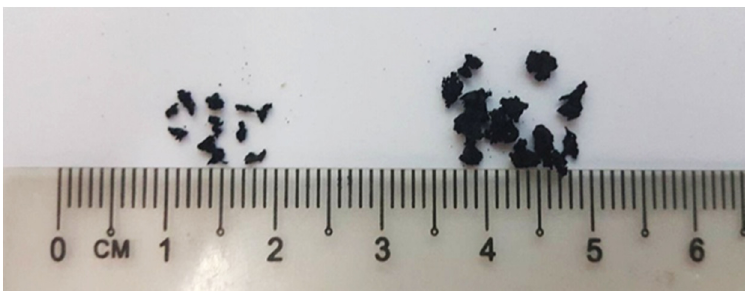
Figure 1. Crumb rubber with size range of 0.6mm to 2.36 mm.